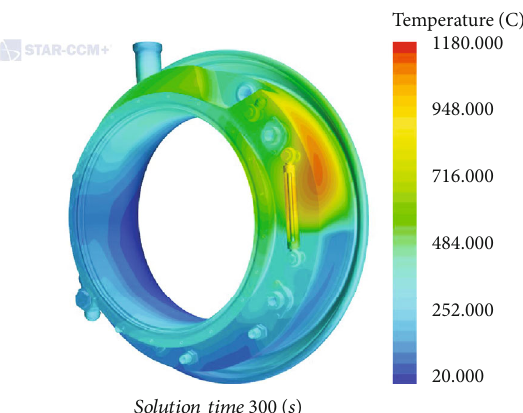
Figure 4: Temperature of the oil tank elements for gauge glass fi re zone at t = 5